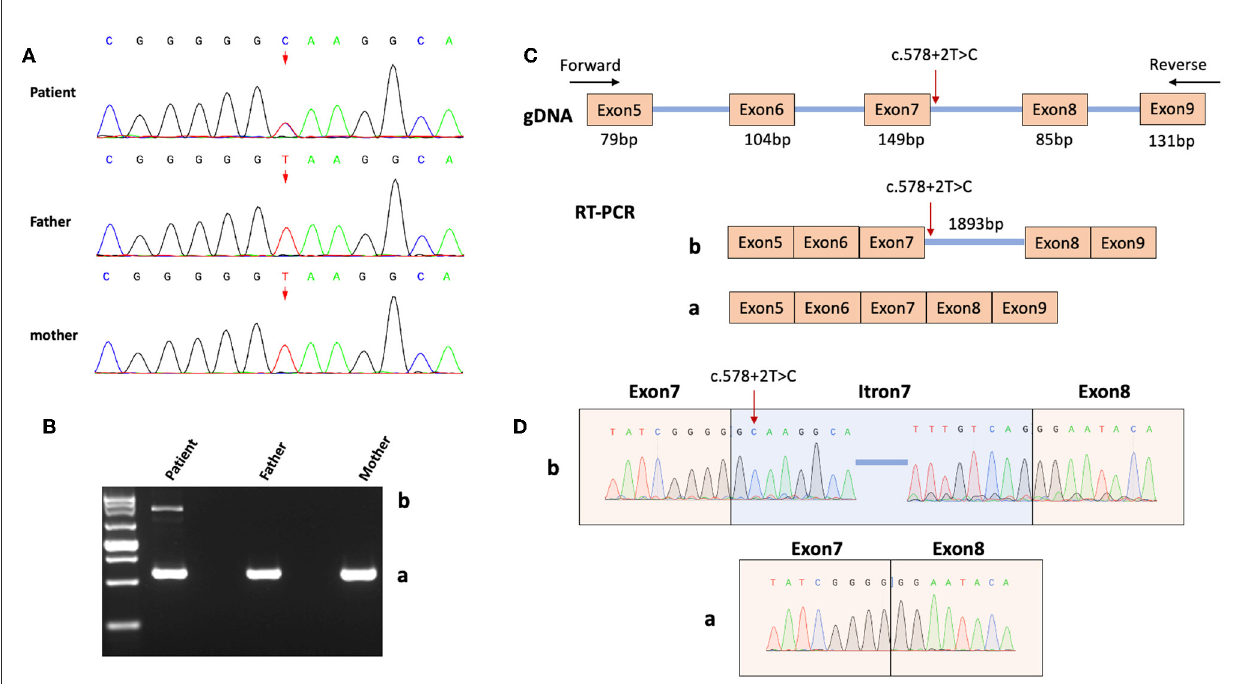
FIGURE2 Genetic diagnosis and RNA analysis. (A) Sanger sequencing results of the patient and his parents. The arrow indicates the genomic location (according to the human genome assembly GRCh37 / hg19) of the heterozygous variant NM_001032221.4:c.578 + 2T > C. (B) RT-PCR product analysis by agarose gel electrophoresis. A normal band (Band a ) was observed in both the male patient and controls (his parents), whereas an extra band (Band b ) was observed in the patient only. (C) A diagram showed the design of PCR primers for cDNA amplification and the contents of the two bands in B (Bands a and b ). Red arrow indicates the variant site. (D) Sanger sequencing revealed the sequences of Bands a and b .